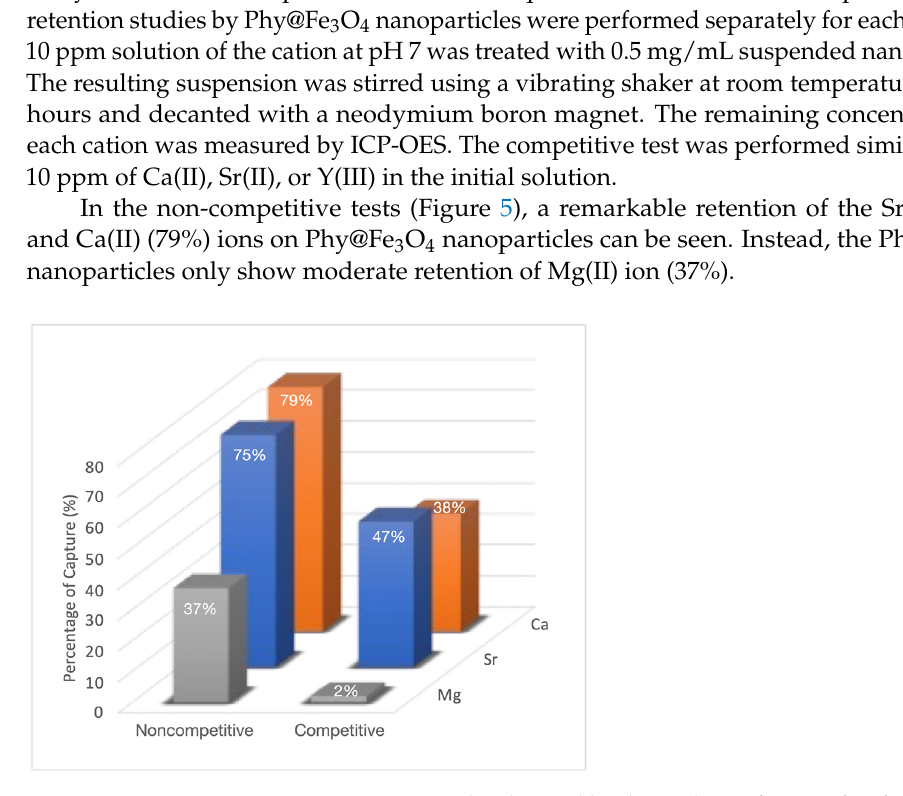
Figure 5. ICP-OES percentage retention results obtained by the analysis of 0.5 mg/L of Phy@Fe 3 O 4 nanoparticles with a 10 ppm of Mg(II), Sr (II) and Ca(II) solution in noncompetitive and competitive media.